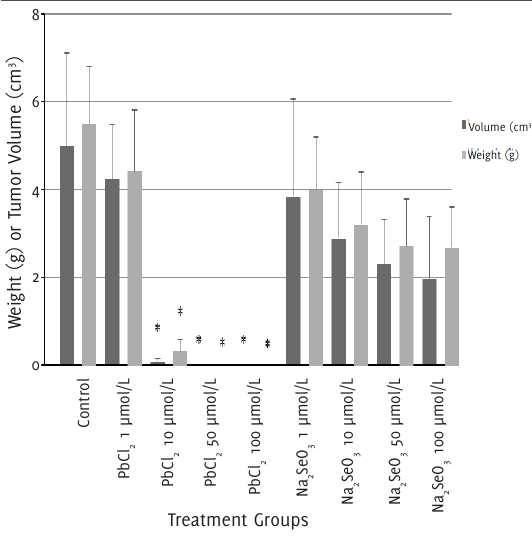
Figure 3. Tumor Weight and Volume after 12 Days of Treatment with a Sin- gle Injection of Lead (II) Chloride (PbCl